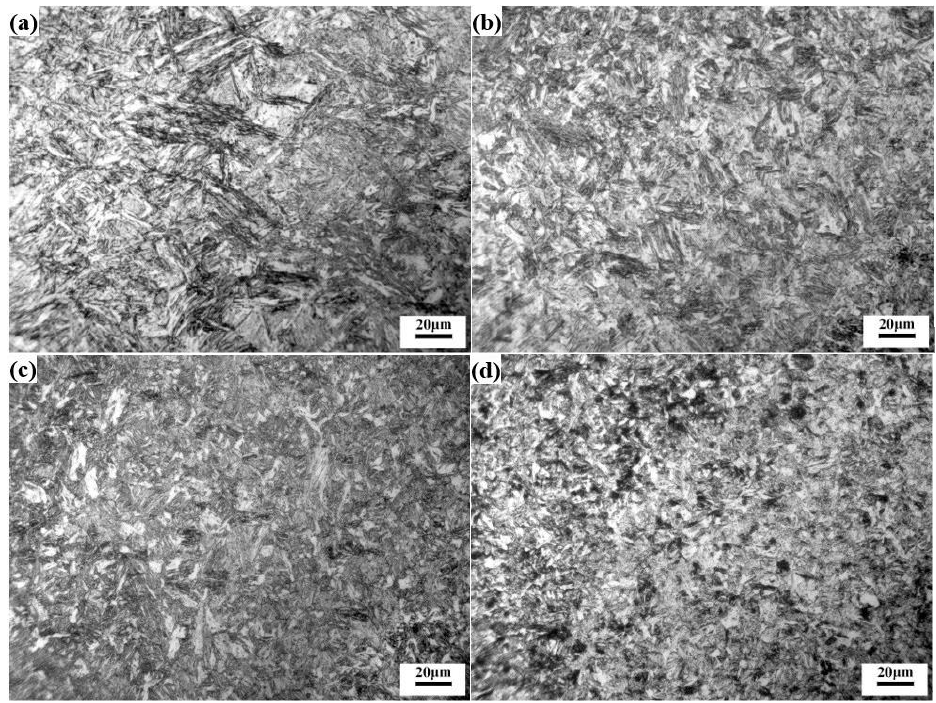
Figure 7. OM images of the fractured specimens at temperature of 950 °C with various strain rates: ( a ) 0.01 s −1 ; ( b ) 0.1 s −1 ; ( c ) 1 s −1 ; ( d ) 10 s −1 .